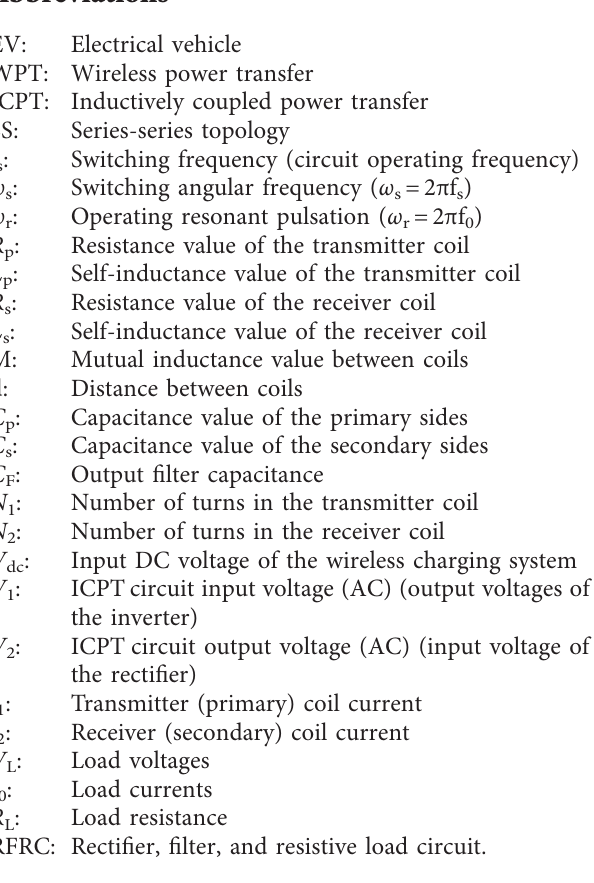
Figure 15: Input and output currents of the ICPTsystem at 15 cm air